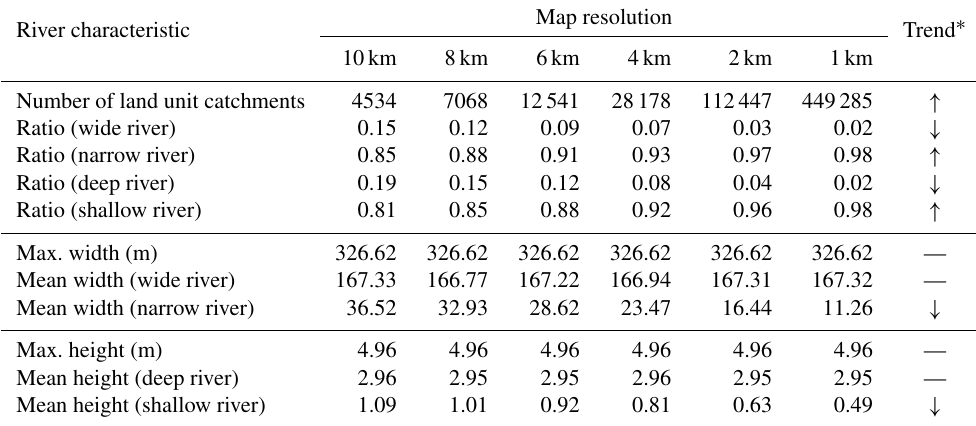
Table 2. Statistical information on the subgrid characteristics of river channels.